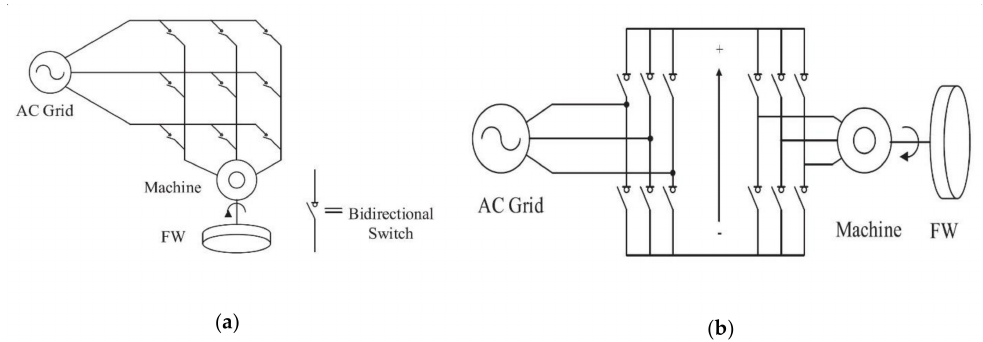
Figure 15. ( a ) Direct matrix converter, ( b ) indirect matrix converter, reproduced with permission from